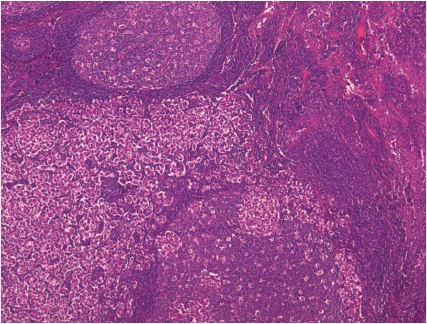
Figure 4: Medium-sized tumor cells with eosinophilic cytoplasm and central nuclei with vesicular chromatin ( × 10; H&E stain).